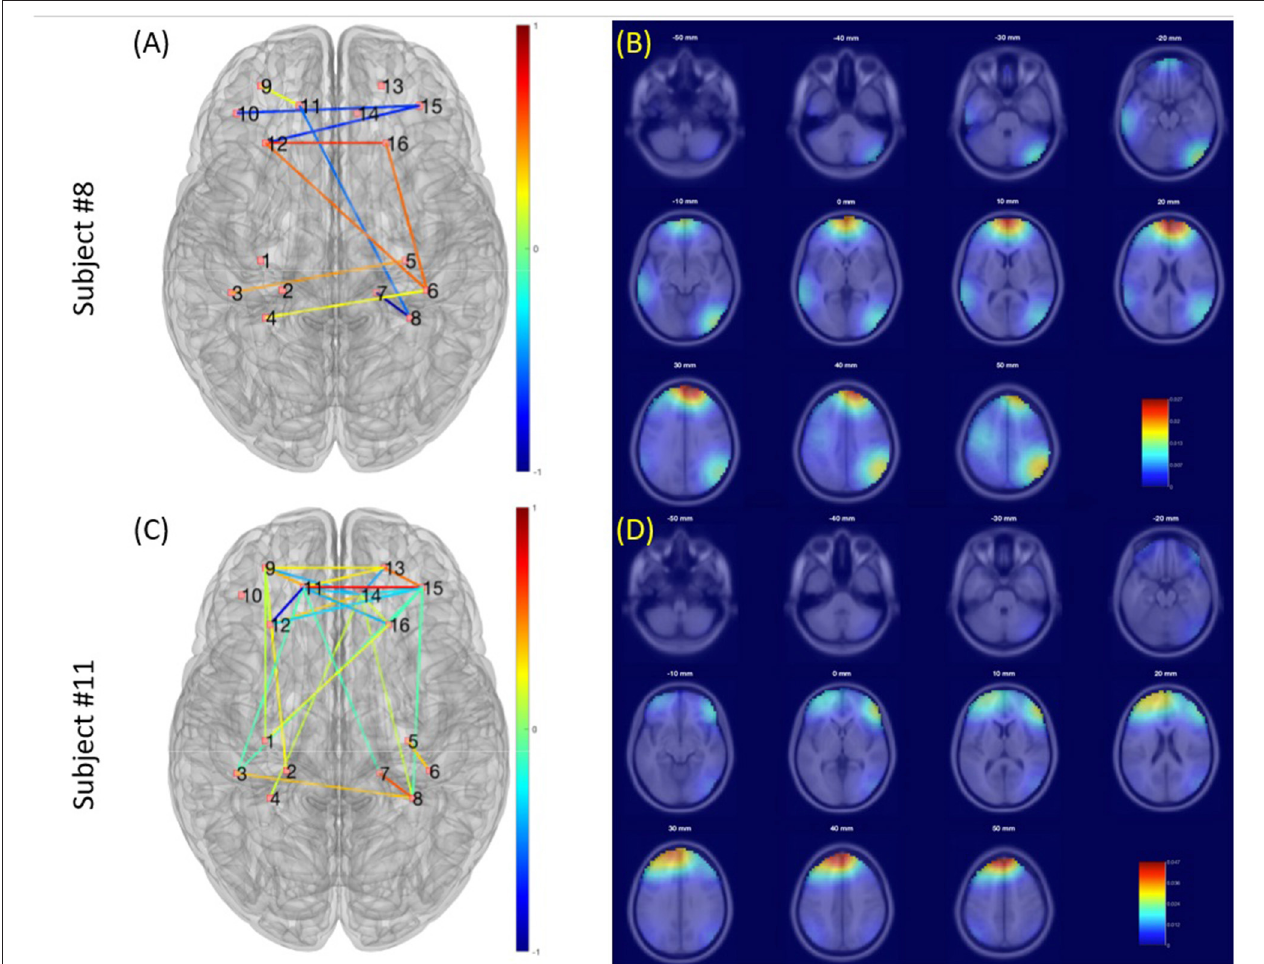
FIGURE 4 | Brain activations during tDCS stimulation (Week 2, 5, and 7 combined). (A,C) Functional connectivity revealed by fNIRS. (B,D) Source localization of EEG signal.